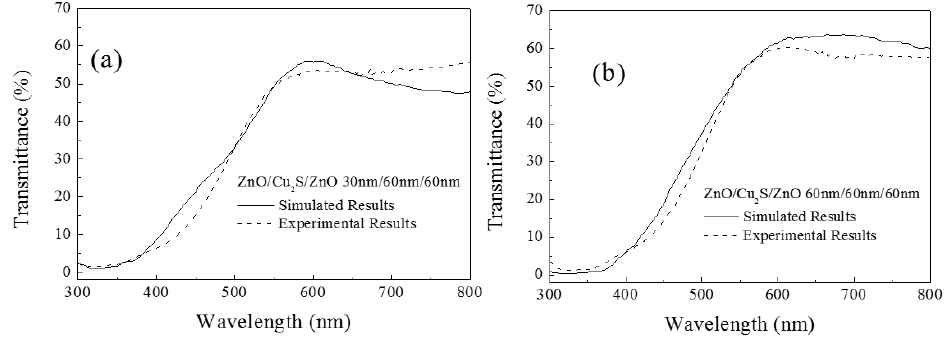
Figure 23. The simulation maximum transmittance of the multilayer on the thickness of top ZnO layer (the thicknesses of middle Cu 2 S is 60 nm and bottom ZnO layer thicknesses is 60 nm for each curve).